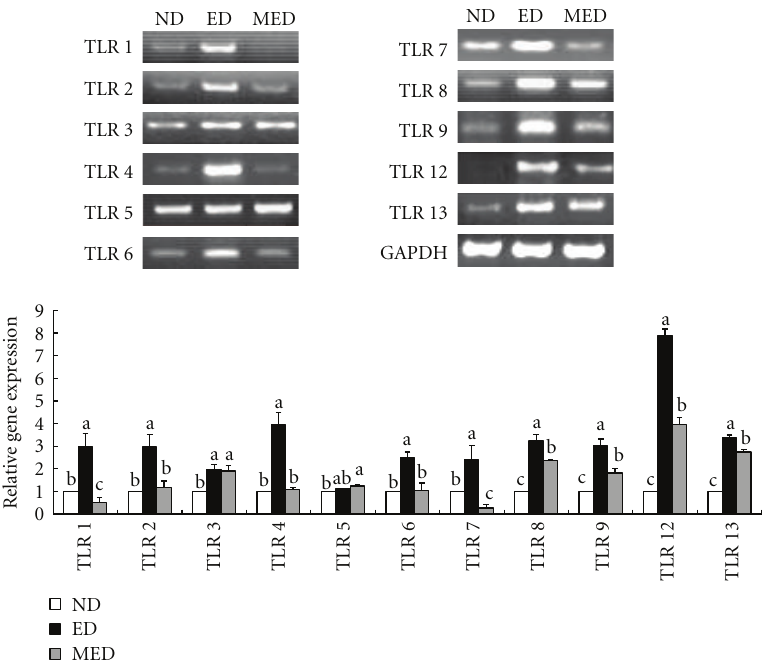
Figure 4: Alcohol-induced liver TLR mRNA expression. The upper panel shows the results of the RT-PCR analysis of the TLR1 ∼ 9, 12, and 13 expressions. The images show the representative agarose gel electrophoresis of the PCR products. The bottom panel shows the relative expressions of the TLR1 ∼ 9, 12, and 13 levels. The data were normalized to the GAPDH levels, and all the expression levels that are shown are relative to the ND. The results that are shown represent the means ± SEM of the three independent experiments in which RNA samples from eight mice were used. a,b,c Means not sharing a common letter are significantly di ff erent ( P < 0 . 05). elevation of the plasma HDL cholesterol